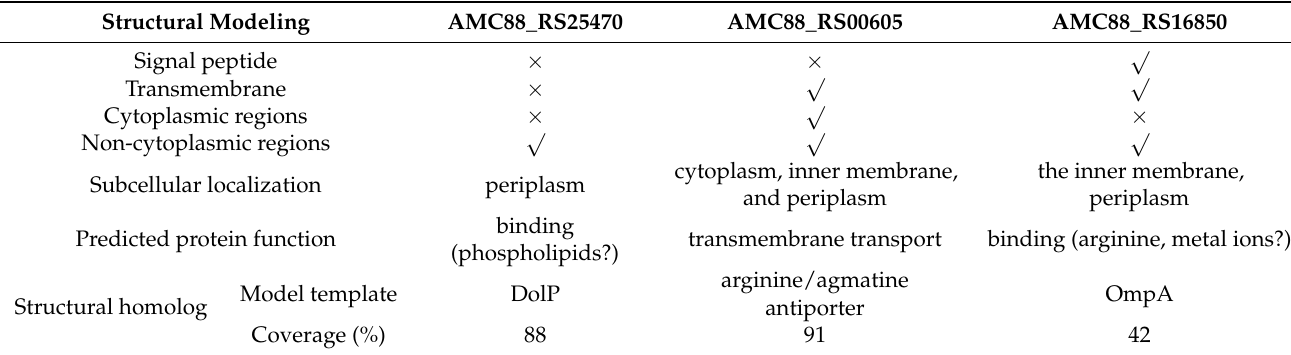
Table 1. Structural prediction of the three proteins whose mRNAs responded most strongly to Al